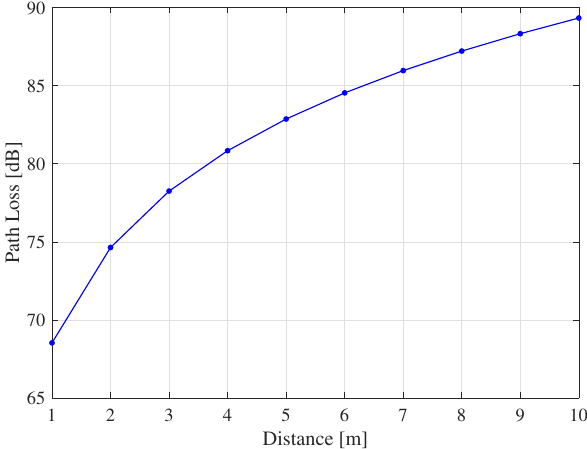
Figure 6. Coverage area of RFID localization system at operating frequency f = 63 GHz.